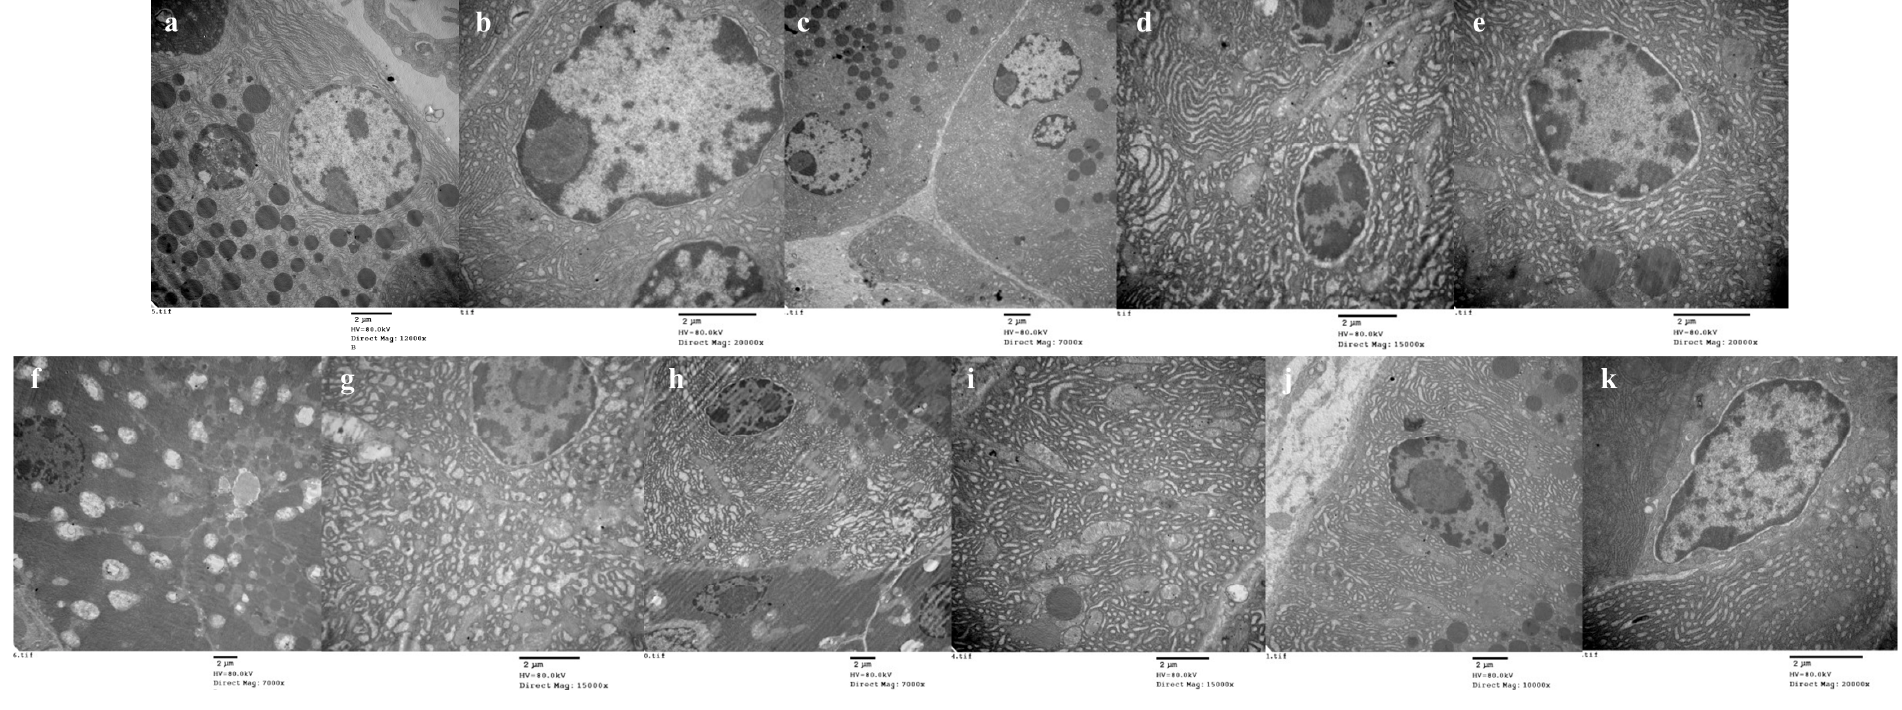
Figure 2. Electron micrographs of mice pancreas. ( a ) Pancreatic ultrastructure of the control group; ( b , d , f , h , j ) Ultrastructure of the pancreas in STI group at 1–5 weeks; ( c , e , g , i , k ) Ultrastructure of the pancreas in STI + VC group at 1–5 weeks.